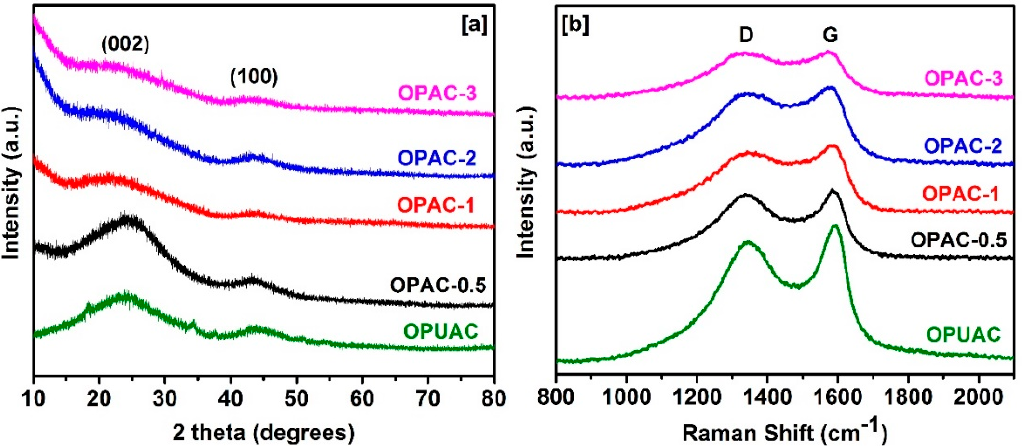
Figure 1. ( a ) XRD spectra and ( b ) Raman spectra of OPUAC and OPACs